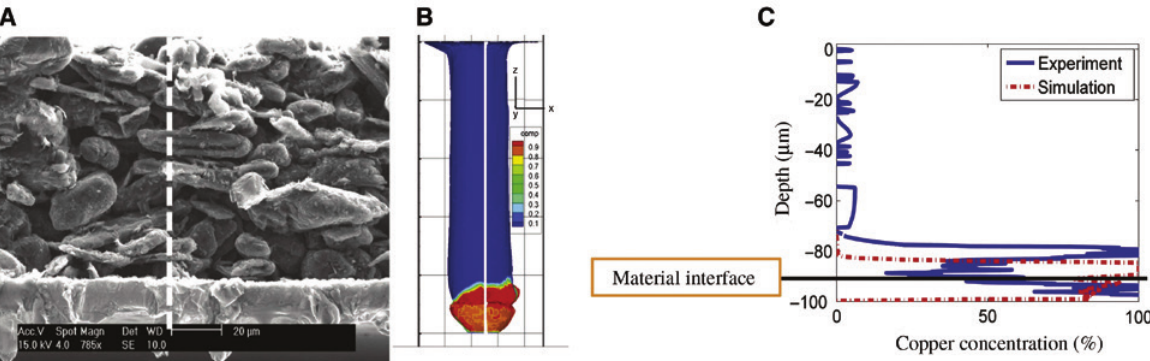
Figure 10: Copper deposition along laser cut graphite anode. (A) SEM image of laser cut anode in cross-section view; (B) copper elemental mapping along cutting kerf (simulation) and (C) comparison of the copper concentration between experiment and simulation. Reprinted from